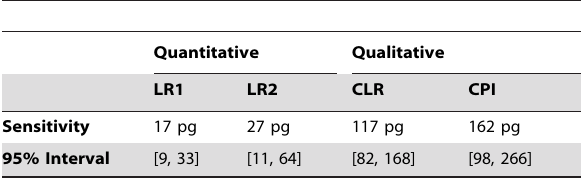
Table 2. The mass detection sensitivity of different DNA mixture interpretation methods.